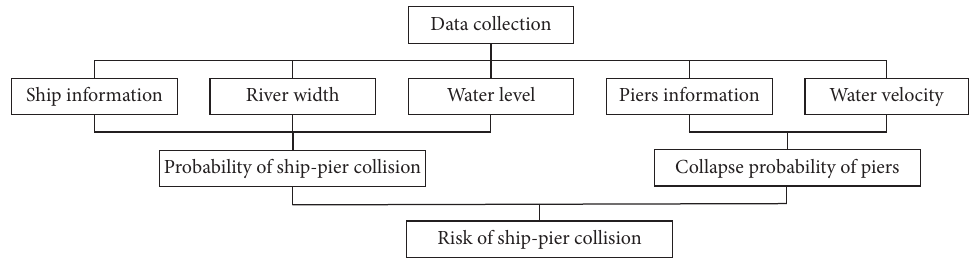
Figure 2: Framework of full probabilistic risk assessment of ship collision with riverside bridges.